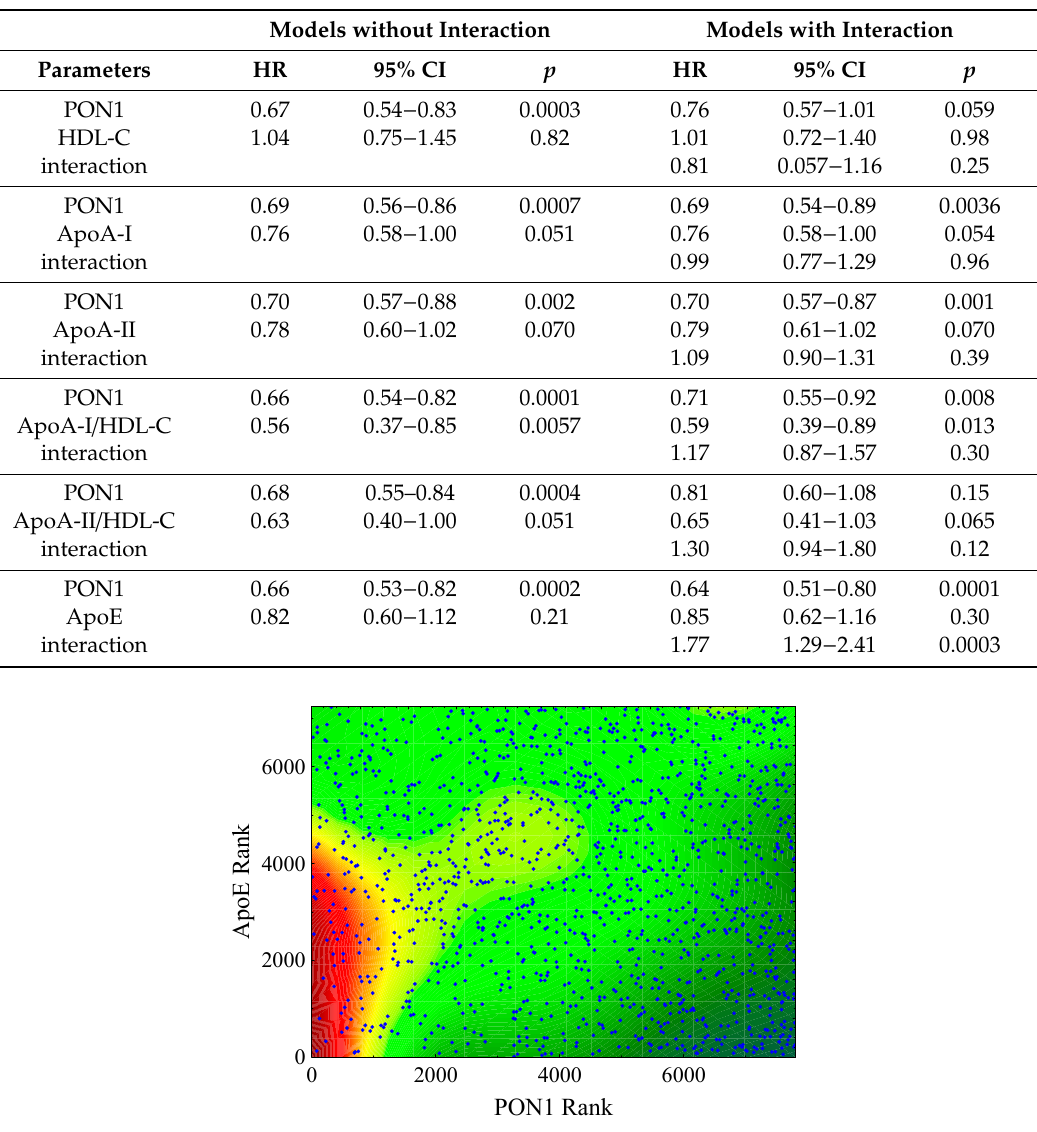
Table 4. Interaction of PON1 with HDL-related parameters for the HR2 population as assessed by Cox proportional hazards models of cardiovascular event occurrence adjusted for gender, age, UAE, past CVD history, diabetes, apoB, statin use, anti-hypertensive use, smoking, ethanol use, eGFR, SBP, and DBP. Hazard ratios are per SD unit. For regression calculations, continuous variables were transformed to distributions with means of zero and SDs of one.